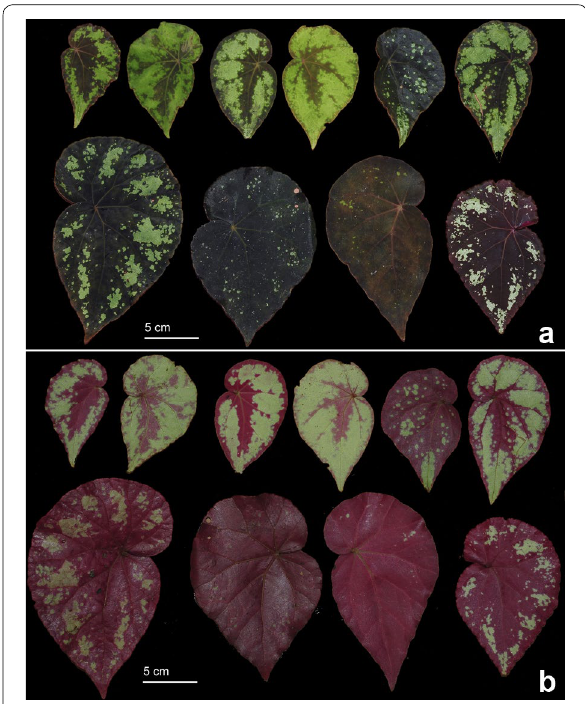
Fig. 7 Begonia sykakiengii R. Rubite, C.‑I Peng, C.W. Lin & K.F. Chung. Leaves photographed in the field to show varied and complex foliar maculation patterns on both surfaces. a Adaxial surface; b abaxial